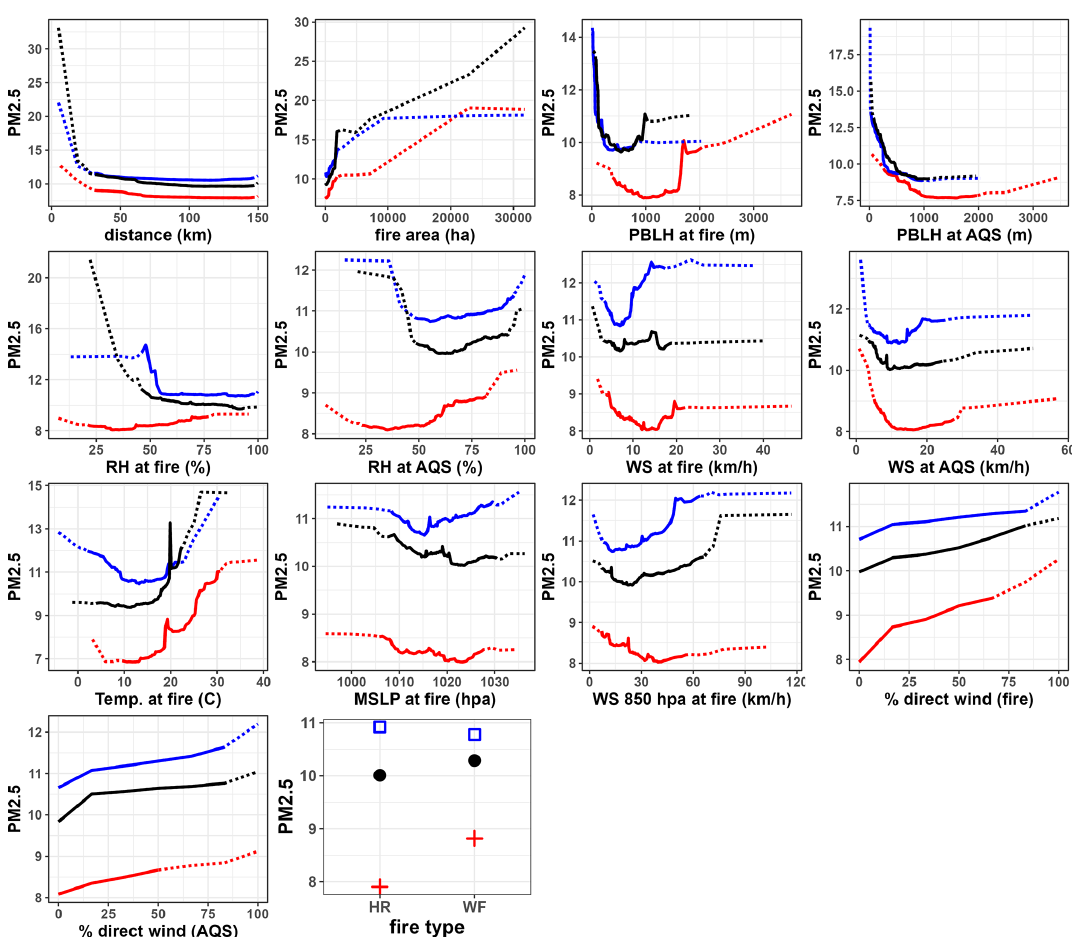
Figure 6. Partial dependence plots for the afternoon (red), night (blue) and morning (black) models. Dotted parts of lines are minimum to the 5th centile and 95th centile to maximum values for each predictor variable, calculated from the training data. Where dotted parts are long, this indicates a large range of values with a small number of observed points for model